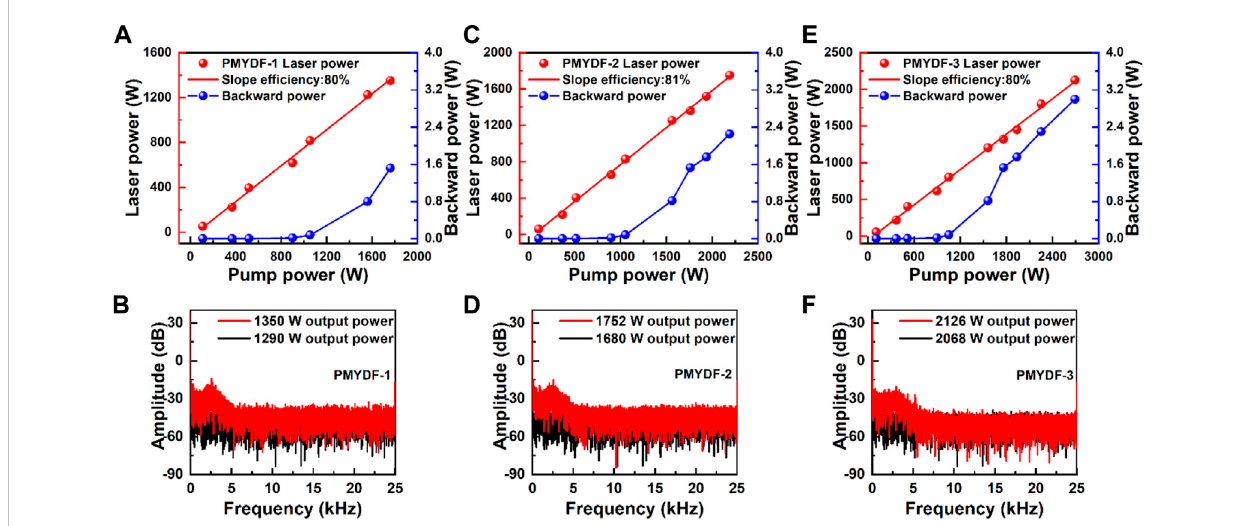
FIGURE 3 ThelaserandbackwardpowerofaMOPA systemversusthepumppowerandthefrequency-domaincharacteristicsoftheampli fi erbyapplyingthe threedifferentNAPMYDFs. (A) ThelaserperformanceofthePMYDF-1. (B) Frequency-domaincharacteristicsbeforeandafterMIbyapplyingthePMYDF- 1. (C) The laser performance of the PMYDF-2. (D) Frequency-domain characteristics before and after MI by applying the PMYDF-2. (E) The laser performance of the PMYDF-3. (F) Frequency-domain characteristics before and after MI by applying the